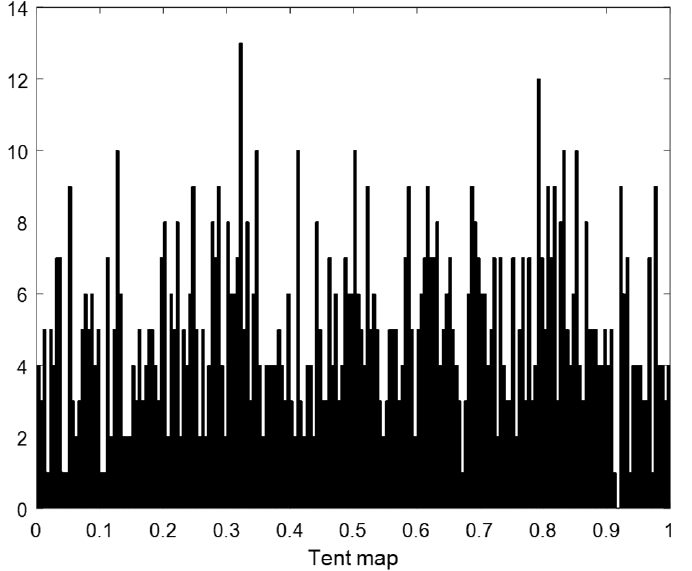
Figure 4. The mapping distribution for α =